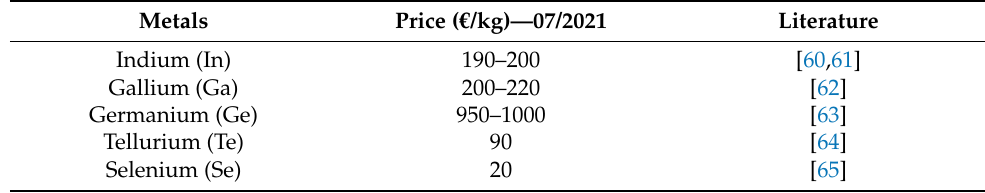
Table 5. Price of metals found in PV.